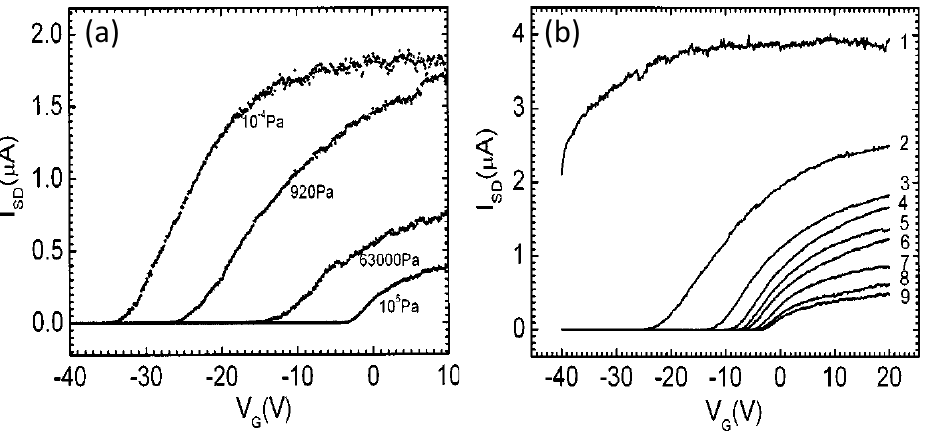
Figure 6. ( a ) Channel current vs. gate voltage under different oxygen pressures. ( b ) Curve